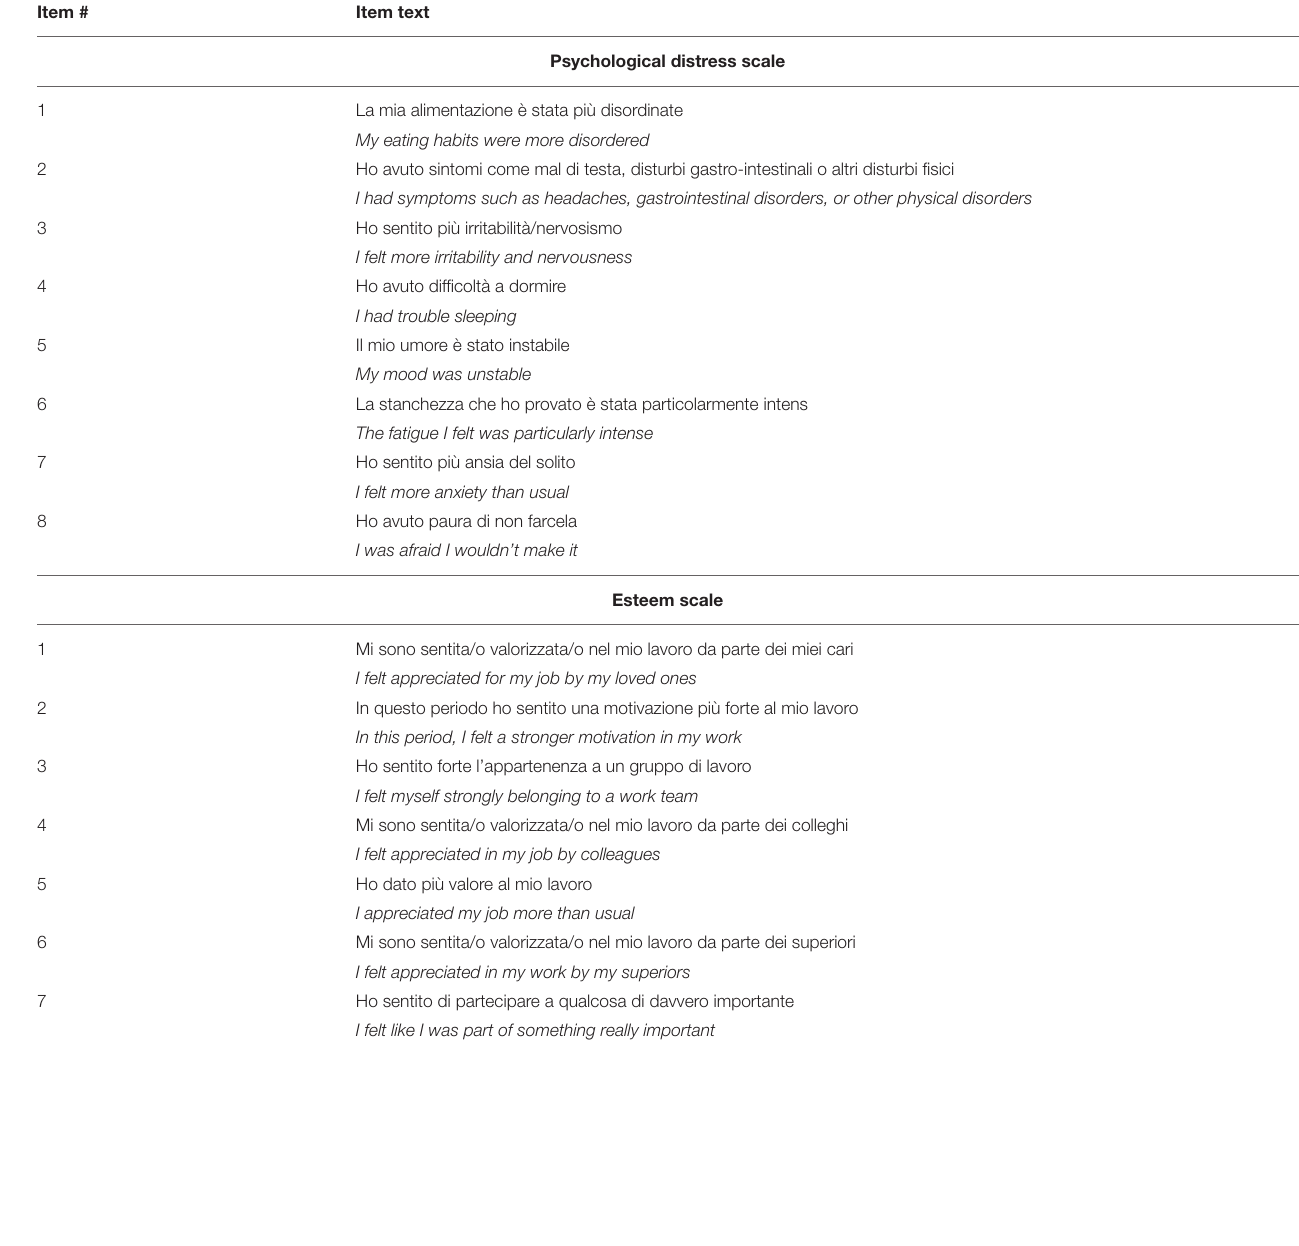
TABLE A1 | Items of the